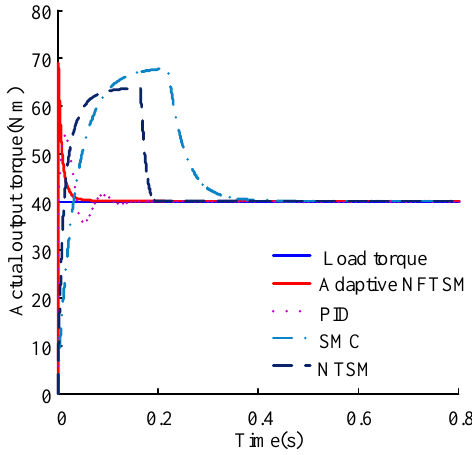
Figure 12. Steering pump speed response when input speed is fixed.